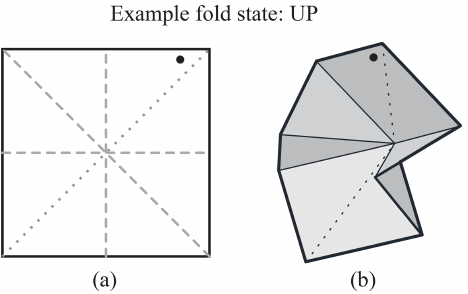
Figure 14. A crease pattern (a) with fold-angle assignment that will result in a UP fold state (b) . The legend for fold-angle assignment is given in Fig. 8. The UP fold state is often used in devices that con- form to the material they contain or support. It also occurs in devices with large cavities, especially those that are non-developable.